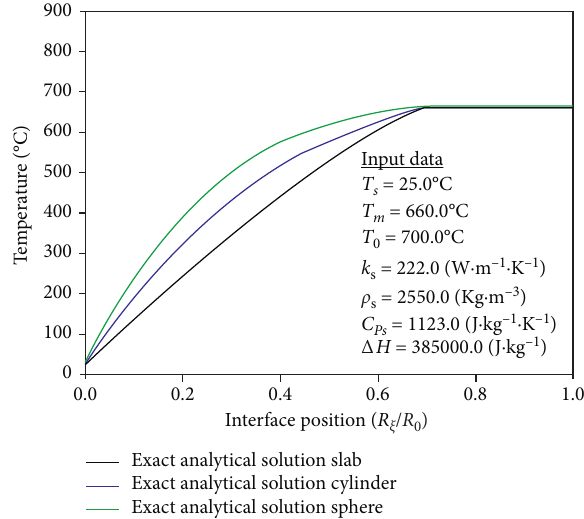
Figure 12: Comparison of concentration profiles during inward single-phase solidification of a slab, a cylinder, and a sphere as a function of dimensionless position ( R